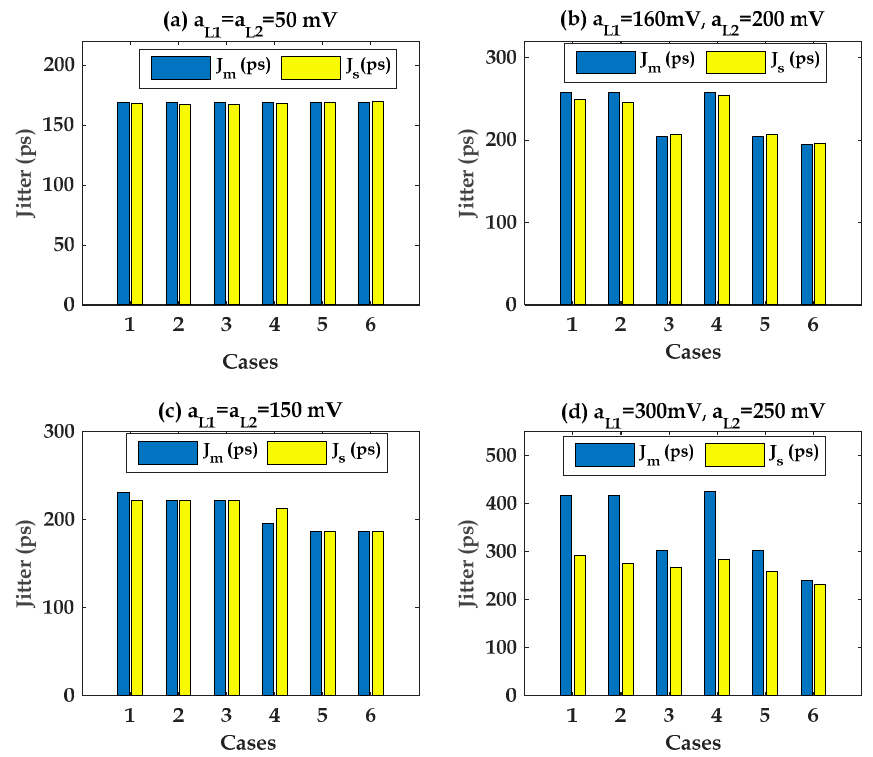
Figure 16. Last-stage case: correlation between J m and J s based on the superposition of (10). ( a , b ), and ( c ): small-signal two tones. ( d ): large-signal case.